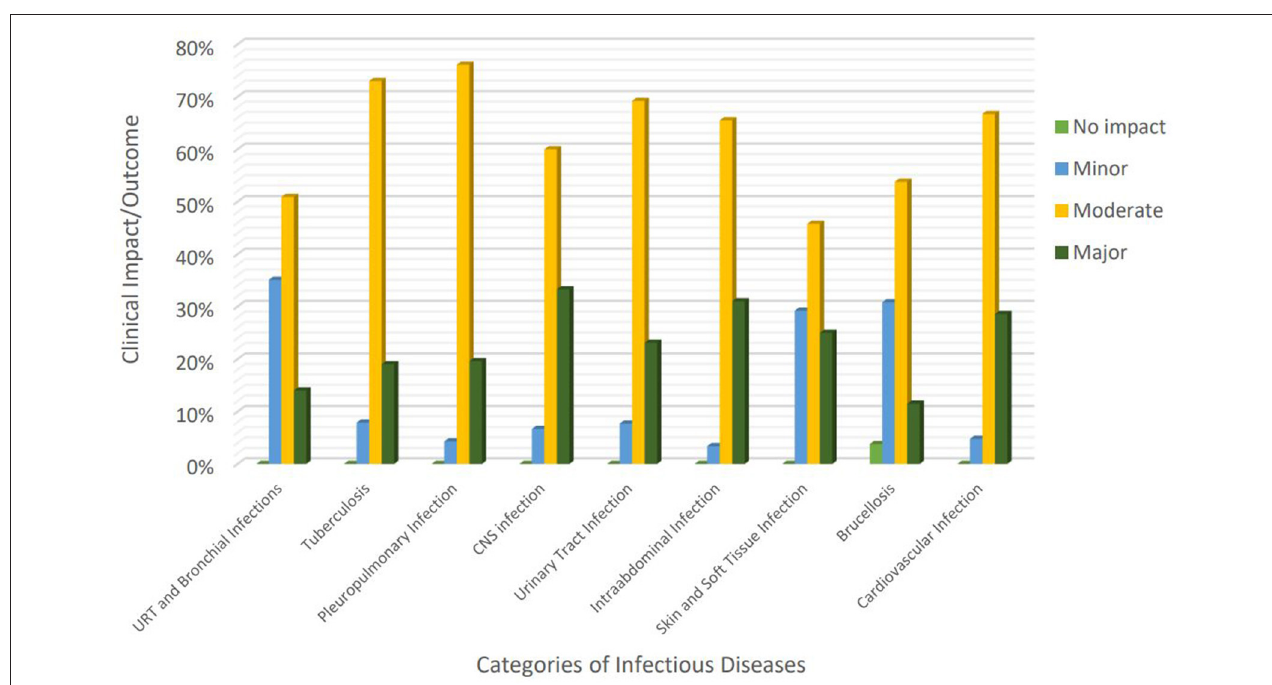
FIGURE 1 | Clinical impact of diagnostic errors regarding the most commonly reported categories of infectious diseases. URTI, Upper Respiratory Tract Infection; CNS, Central Nervous System; GI, Gastrointestinal.